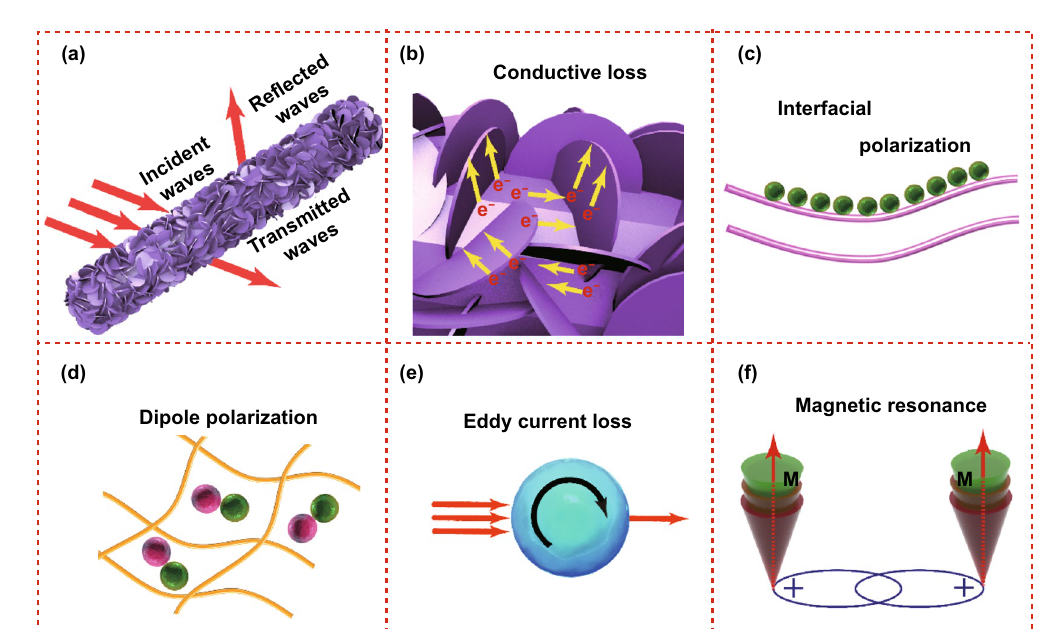
Scheme 2 EM wave absorption mechanism of S-2